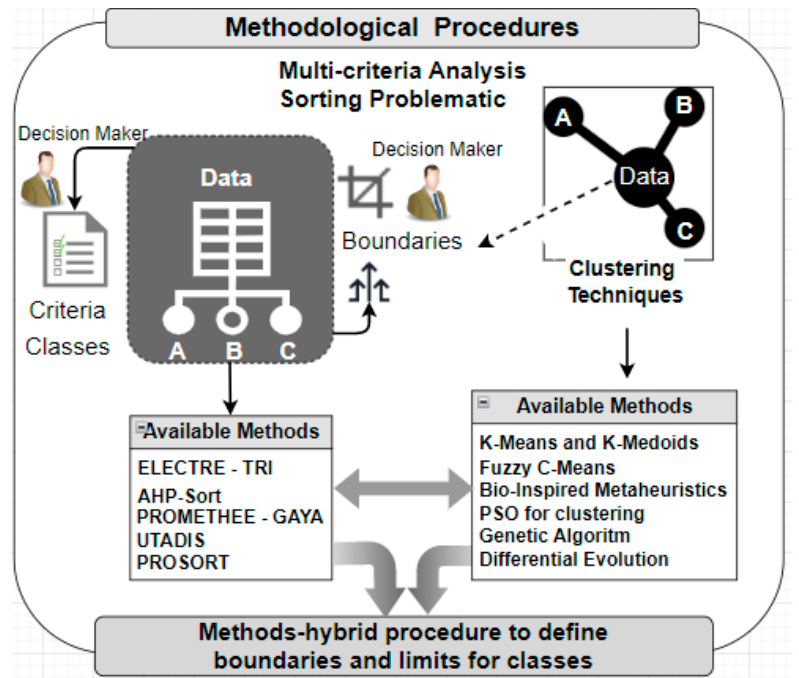
Figure 2. Methodological Context.